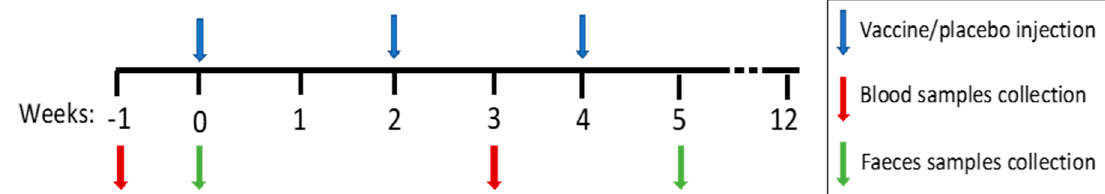
Figure 1. Study samples collection. Weeks − 1 and 0 corresponded to the baseline of the study, and weeks 3 and 5 corresponded to the postvaccination points. Feces samples were collected at week 0 (baseline) and week 5 (postvaccination), indicated by the green arrows. Blood samples were collected at week − 1 (baseline) and week 3 (postvaccination), indicated by the red arrows. The vaccine or placebo were injected at weeks 0, 2, and 4, indicated by the blue arrows.